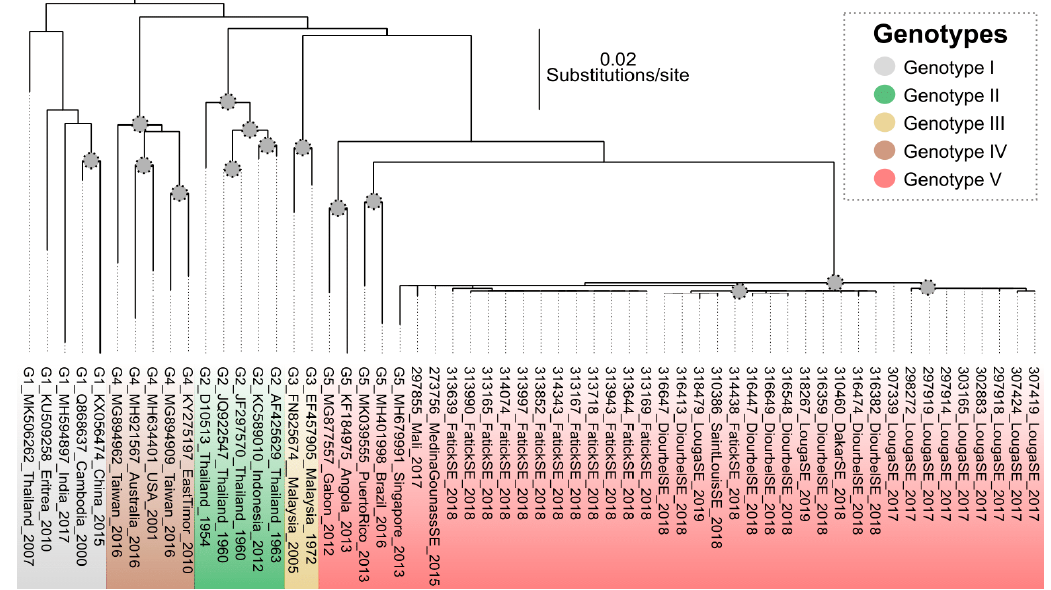
Figure 2. Maximum likelihood viral genealogy inferred using the sequences from Senegal and Mali and strains representa- tive of described genotypes. Grey circle on nodes represent bootstrap values greater than 75. The scale bar represents the number of substitutions per site.